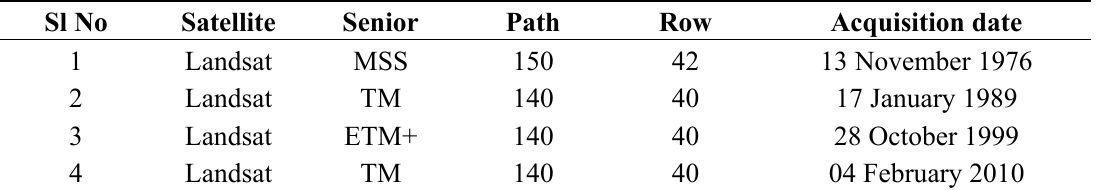
Table 1. List of Landsat imagery considered for